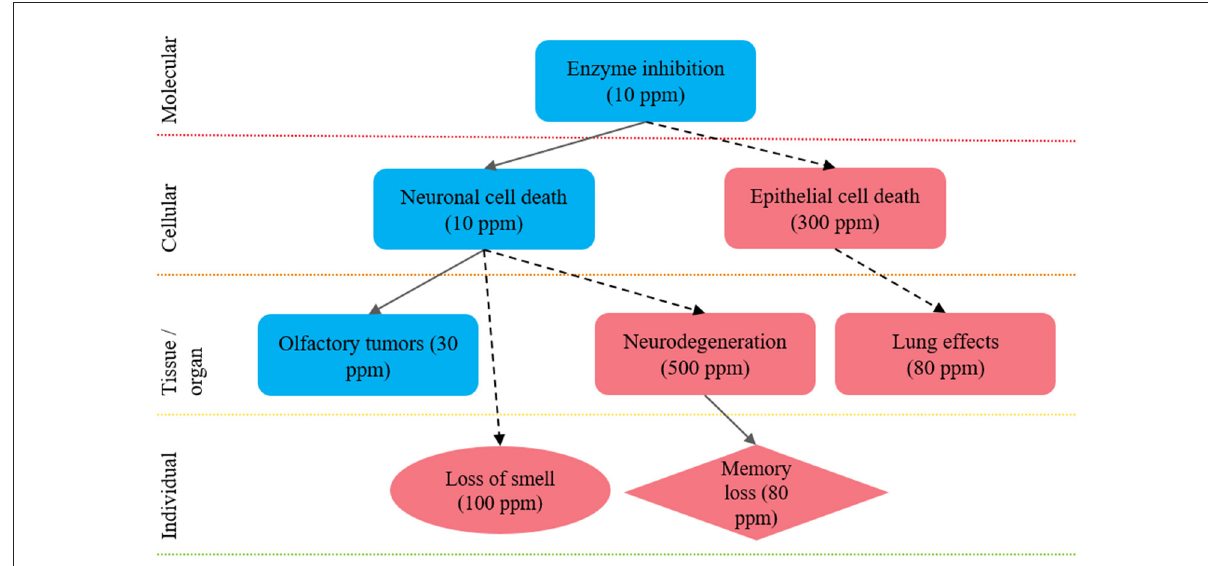
FIGURE3 Integration of health effects into a biological pathway network to inform future selection of a point of departure: example biological pathway network approach to integrate health effect data derived from distinct LOEs to inform selection of a health-protective POD. The key events shown here are proposed to lead to hallmark effects associated with hydrogen sulfide exposure: nasal tissue outcomes; neurological tissue outcomes and pulmonary tissue outcomes. The shape of each key event indicates the LOE: rectangle, animal data; circle, epidemiological data; and diamond, both animal and epidemiological data. The level of evidence supporting linkages between key events is shown by the arrows: solid arrows, quantitative evidence; dotted arrows, qualitative evidence. The color of each shape reflects a relative distinction between high- and low-dose effects, where effects observed at < 30 ppm are considered low dose effects (blue) and effects observed at > 30 ppm are considered high-dose effects (red). Figure adapted from Goyak and Lewis